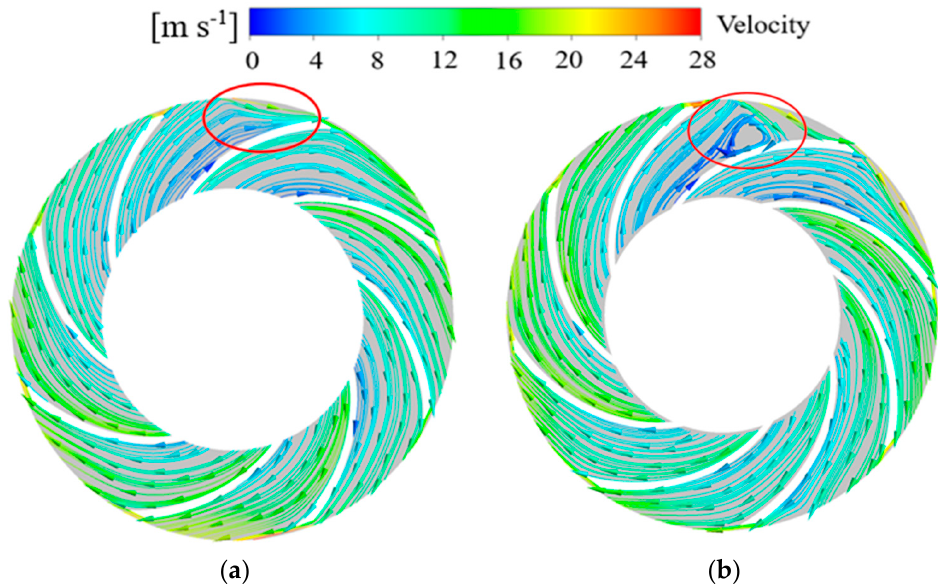
Figure 11. Comparison of the second-stage impeller velocity distribution before ( a ) and after ( b ) optimization.